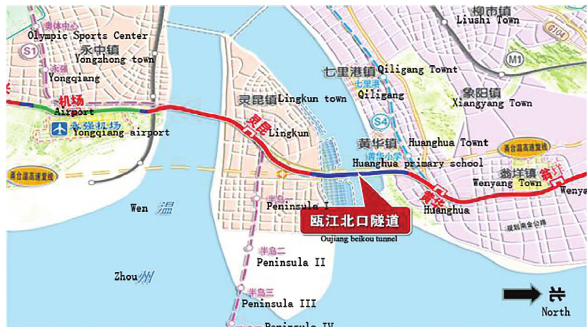
Figure 1: Schematic diagram of the location of Oujiang Beikou